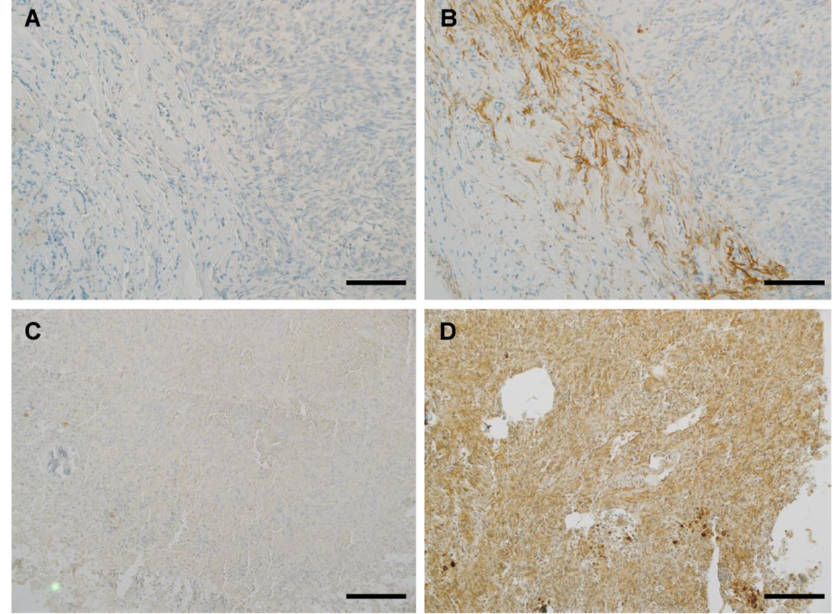
Figure 7. Representative meningioma samples, MGM-2 ( A , B ) and MGM-7 ( C , D ), were stained separately with MRQ-67 ( A , C ) and H09 ( B , D ), with some disturbing nonspecific stain observed with H09 (scores of 2 and 2.5 as shown in ( B , D ), respectively), but not with MRQ-67 (scores of 0 and 0.5 in ( A , C ), respectively), mainly at some fibrotic components. UltraView, visualized with DAB, and counterstained with hematoxylin. ( A , B ) scale bar = 100 µ m; ( C , D ) scale bar = 200 µ m.